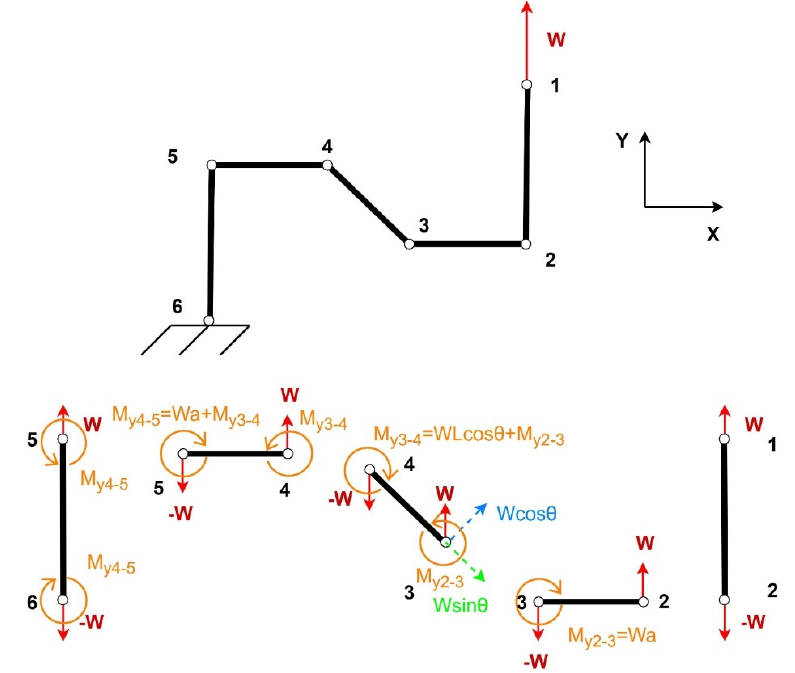
Figure 3. Free body diagram for loading in the y-direction.